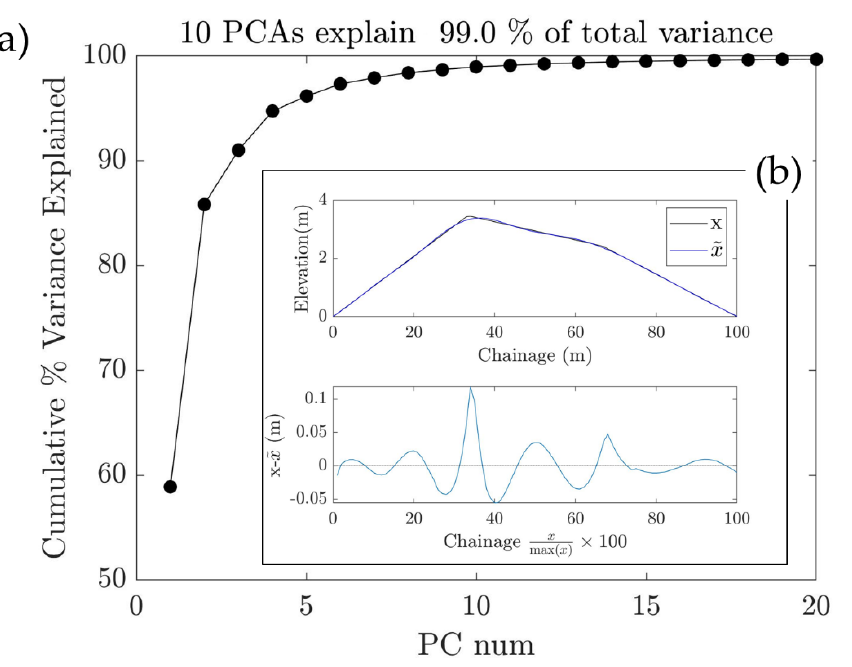
Figure 7. The Principal Component Analysis (PCA) suggests that we can capture the majority of the variability observed on the de-trended elevation profiles with a reduced number of Principal Components (PCs): ( a ) percentage of variability explained by the first 20 PCs. The percent of cumulative variance explained is on the y-axis, and the Principal Component (PC) number is on the x-axis; ( b ) comparison of one of the original elevation profiles, x, versus the reconstructed, 𝑥̃ , using the first 10 PCs. Top panel shows the elevation profile, and bottom panel, the absolute difference between the original and reconstructed.